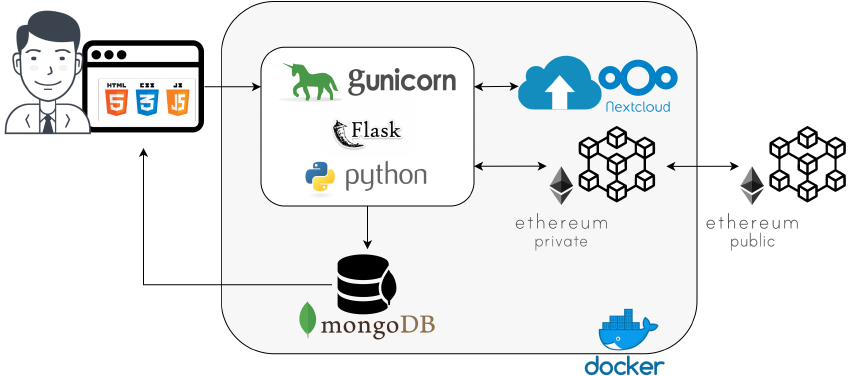
Figure 4. Hospital Cloud software